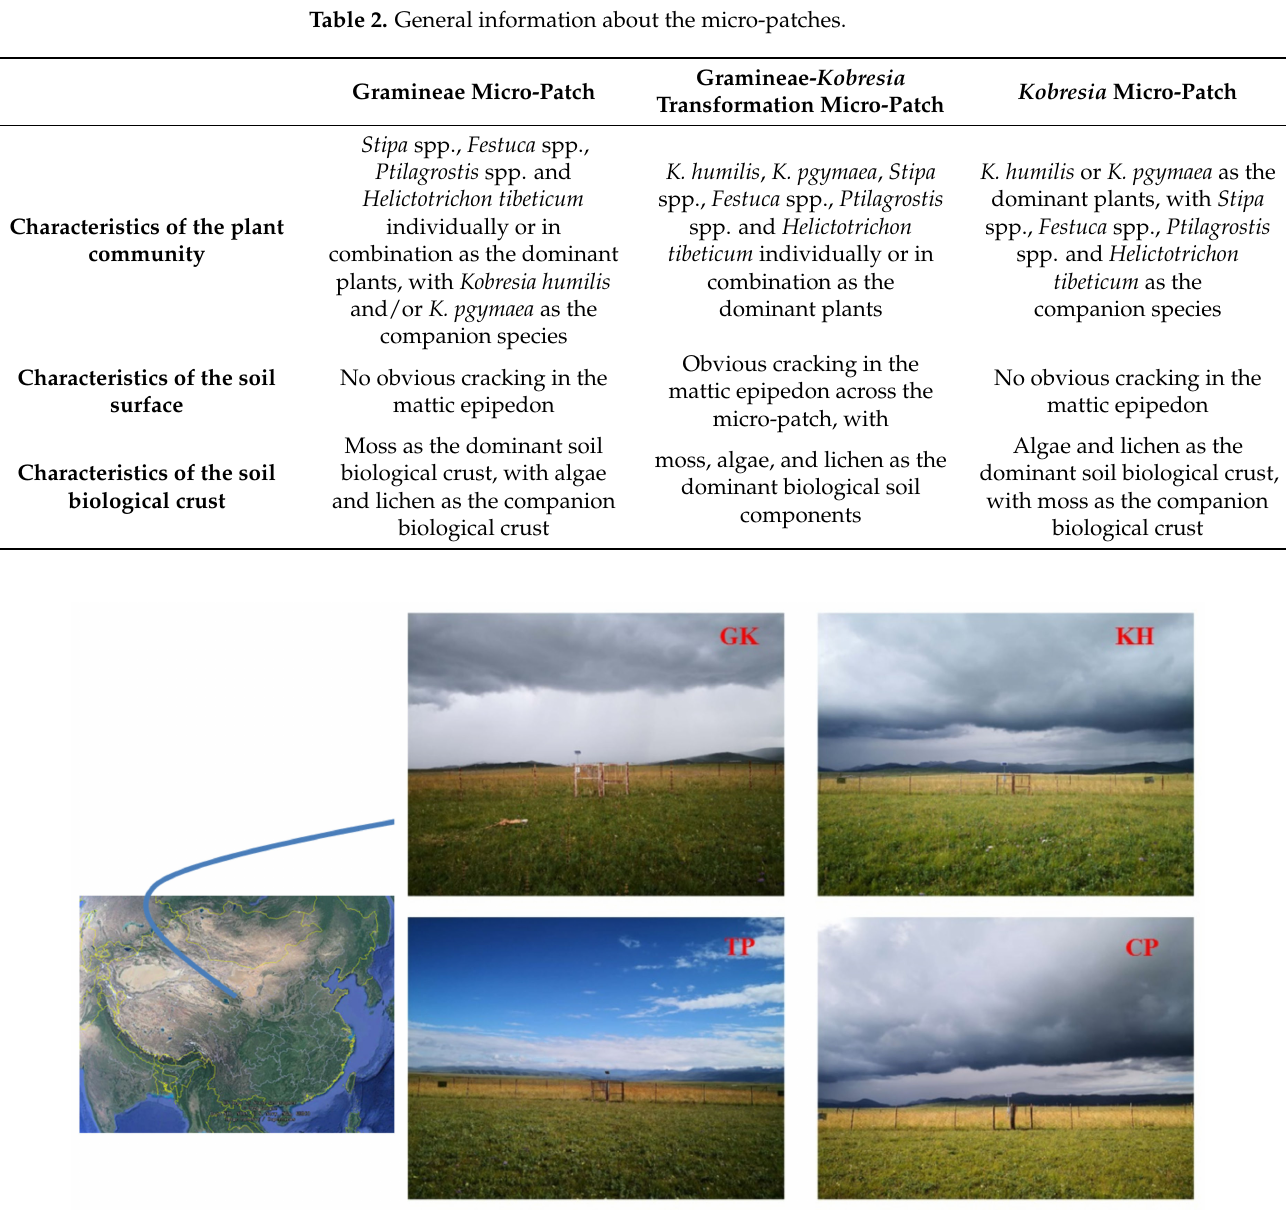
Table 2. General information about the micro-patches.